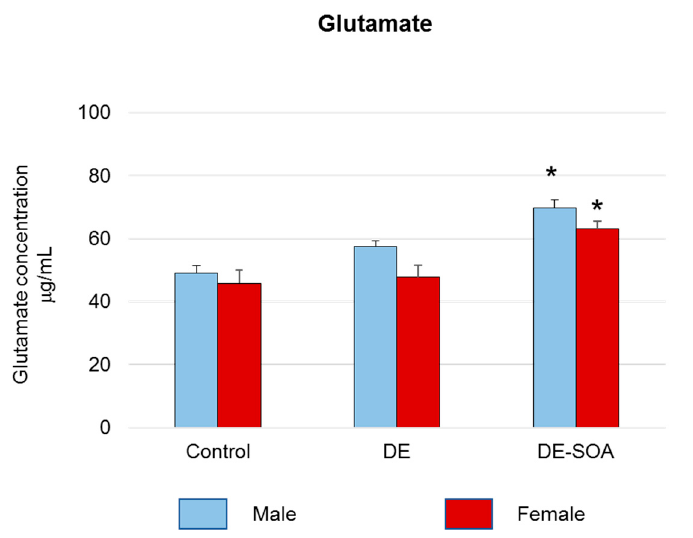
Figure 6. Assessment of neurotoxic substance in the brain. Glutamate concentration in the prefrontal cortex of the control and the DE ‐ and DE ‐ SOA ‐ exposed male and female rats ( n = 6, * p < 0.05 vs. corresponding control).